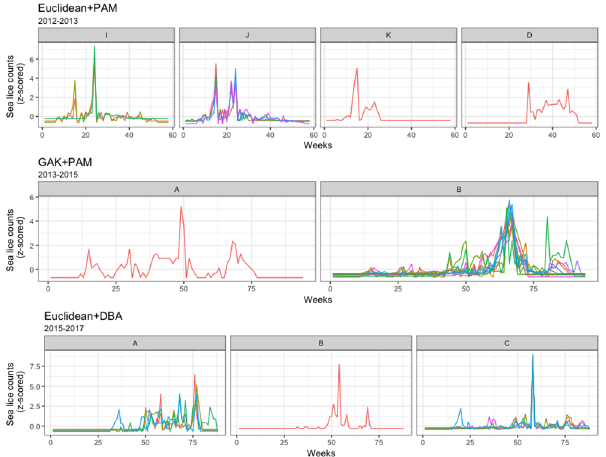
Fig 5. Farm II clustering per production cycle. Time series plots for the most stable clustering algorithm for Farm II, one from each production cycle.